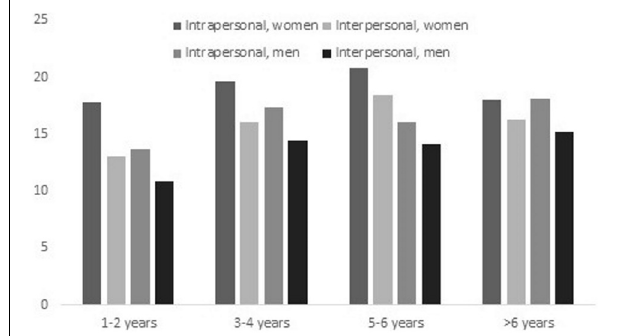
FIGURE 1 | Brazilian–Portuguese IRSS domains by gender and duration of